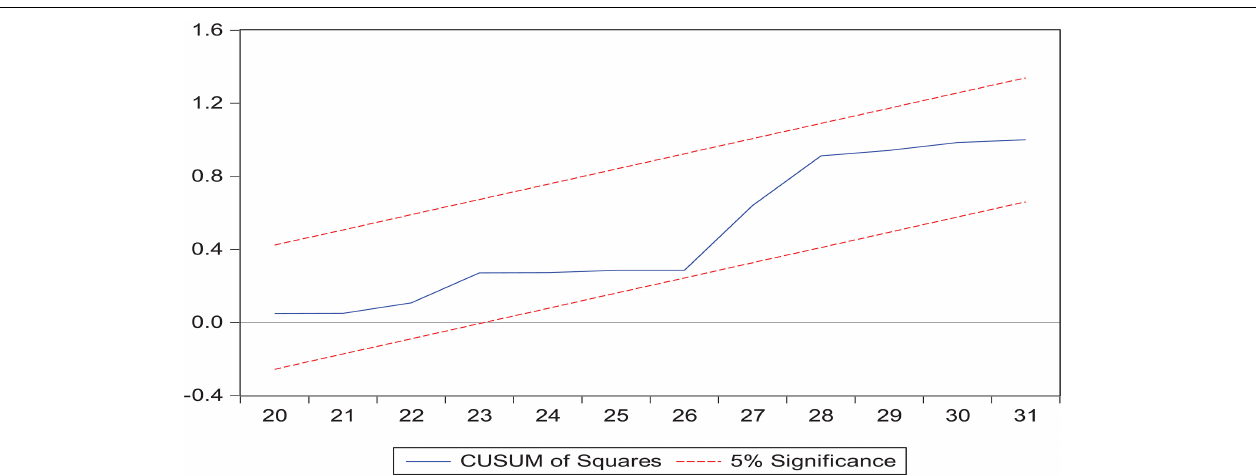
FIGURE 1 | Total cases (WHO: April 30, 2021).